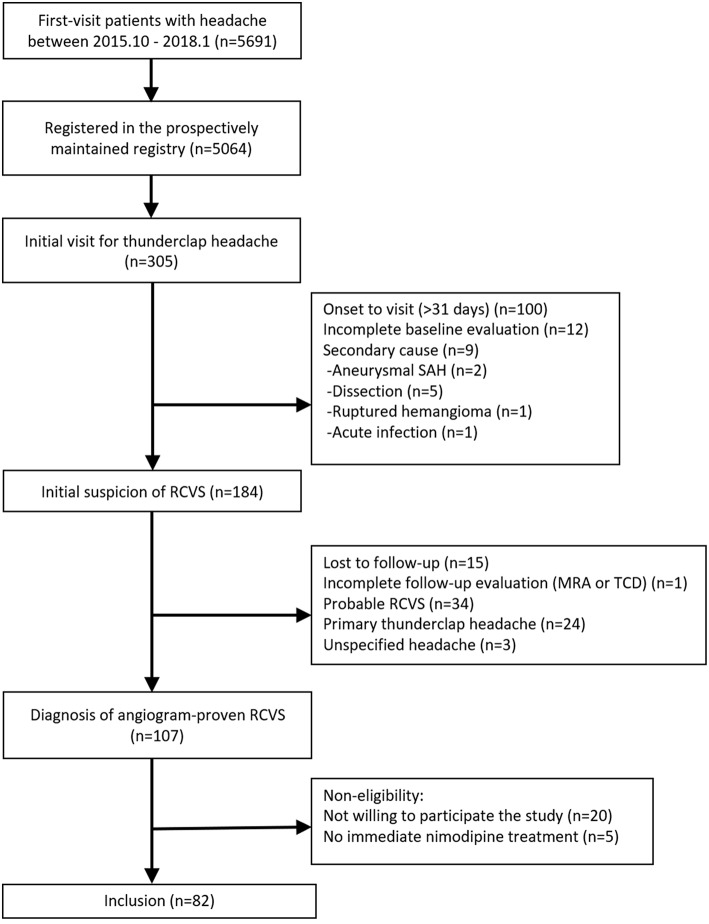
Flow diagram of the study.